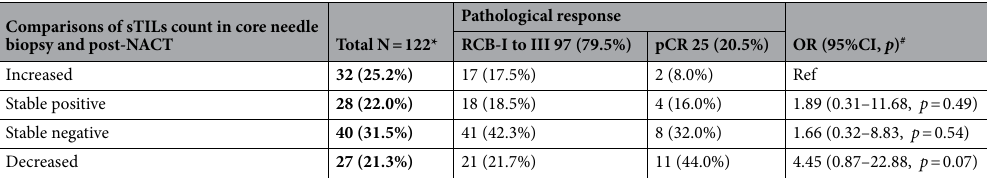
Table 5. Comparisons of sTIL counts in core needle biopsy and post-NACT surgical specimen according to residual cancer burden (RCB). Values in bold indicate data of statistical significance. *Five women with RCB had no tissue post-NACT for sTILs evaluation; Ref: reference value. pCR: pathological complete response; RCB: residual cancer burden; sTILs: stromal tumor infiltrating lymphocytes; NACT: neoadjuvant chemotherapy. #p value calculation using Pearson’s Chi-squared test.